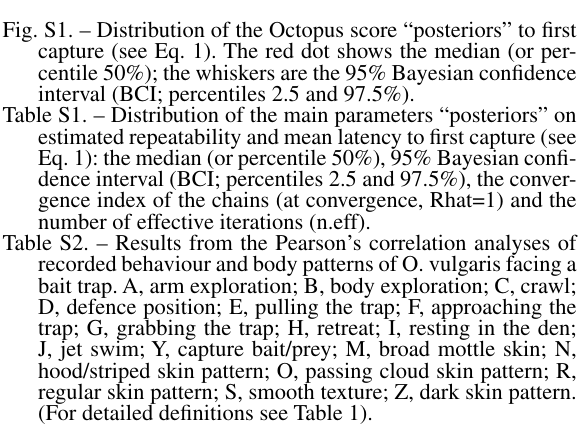
Table S2. – Results from the Pearson’s correlation analyses of recorded behaviour and body patterns of O. vulgaris facing a bait trap. A, arm exploration; B, body exploration; C, crawl; D, defence position; E, pulling the trap; F, approaching the trap; G, grabbing the trap; H, retreat; I, resting in the den; J, jet swim; Y, capture bait/prey; M, broad mottle skin; N, hood/striped skin pattern; O, passing cloud skin pattern; R, regular skin pattern; S, smooth texture; Z, dark skin pattern. (For detailed definitions see Table